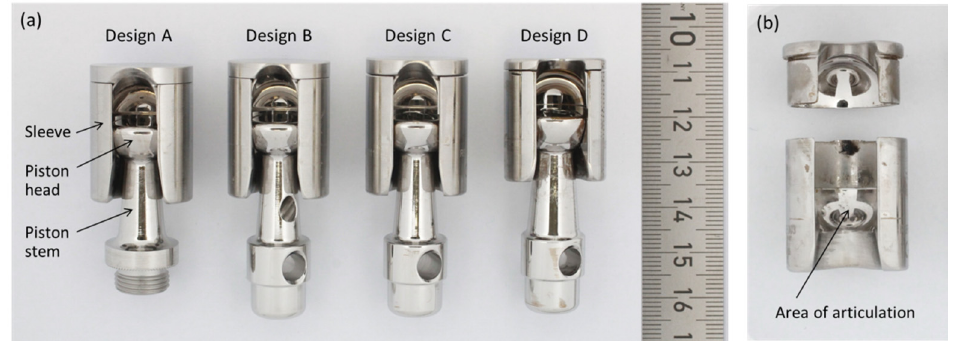
Figure 1. ( a ) Metal-on-metal (MoM) coupling mechanisms consisting of piston and sleeve. The four design variations from our cohort are displayed. Design A refers to the oldest modification, while design D is the most recent. ( b ) The sleeve after separation of the lid for quantitative wear analysis. The arrow indicates the articulating counter face, which was investigated by a coordinate measuring machine (CMM).